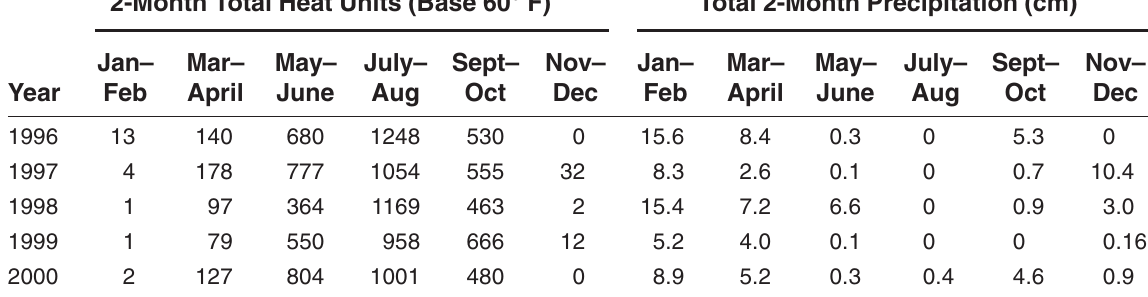
2-Month Total Heat Units (Base 60°F) and Precipitation at the West Side Research and Extension Center Site for the Years 1996 Through 2000